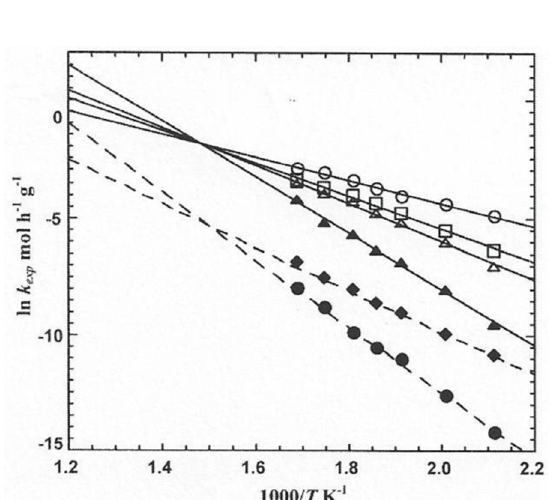
Figure 1. Arrhenius lines describing the hydrodechlorination of chlorobenzene over supported nickel. The upper four systems result in an isokinetic temperature of 669 ± 2 K. The symbols there are arranged in the following order downwards from the highest to the lowest level: Ni/AC; Ni/SiO 2 ; Ni/MgO; Ni/Ta 2 O 3 . The lines of the two remaining systems, Ni/Al 2 O 3 and Ni/graphite, have been shifted downwards by 3 ordinate units (for purposes of clarity). Since there are only two lines that intersect, this crossing point is regarded as being less accurate than the upper one. (Figure 1 is from Figure 5 in Ref. [18], with the courtesy by Elsevier B.V.).